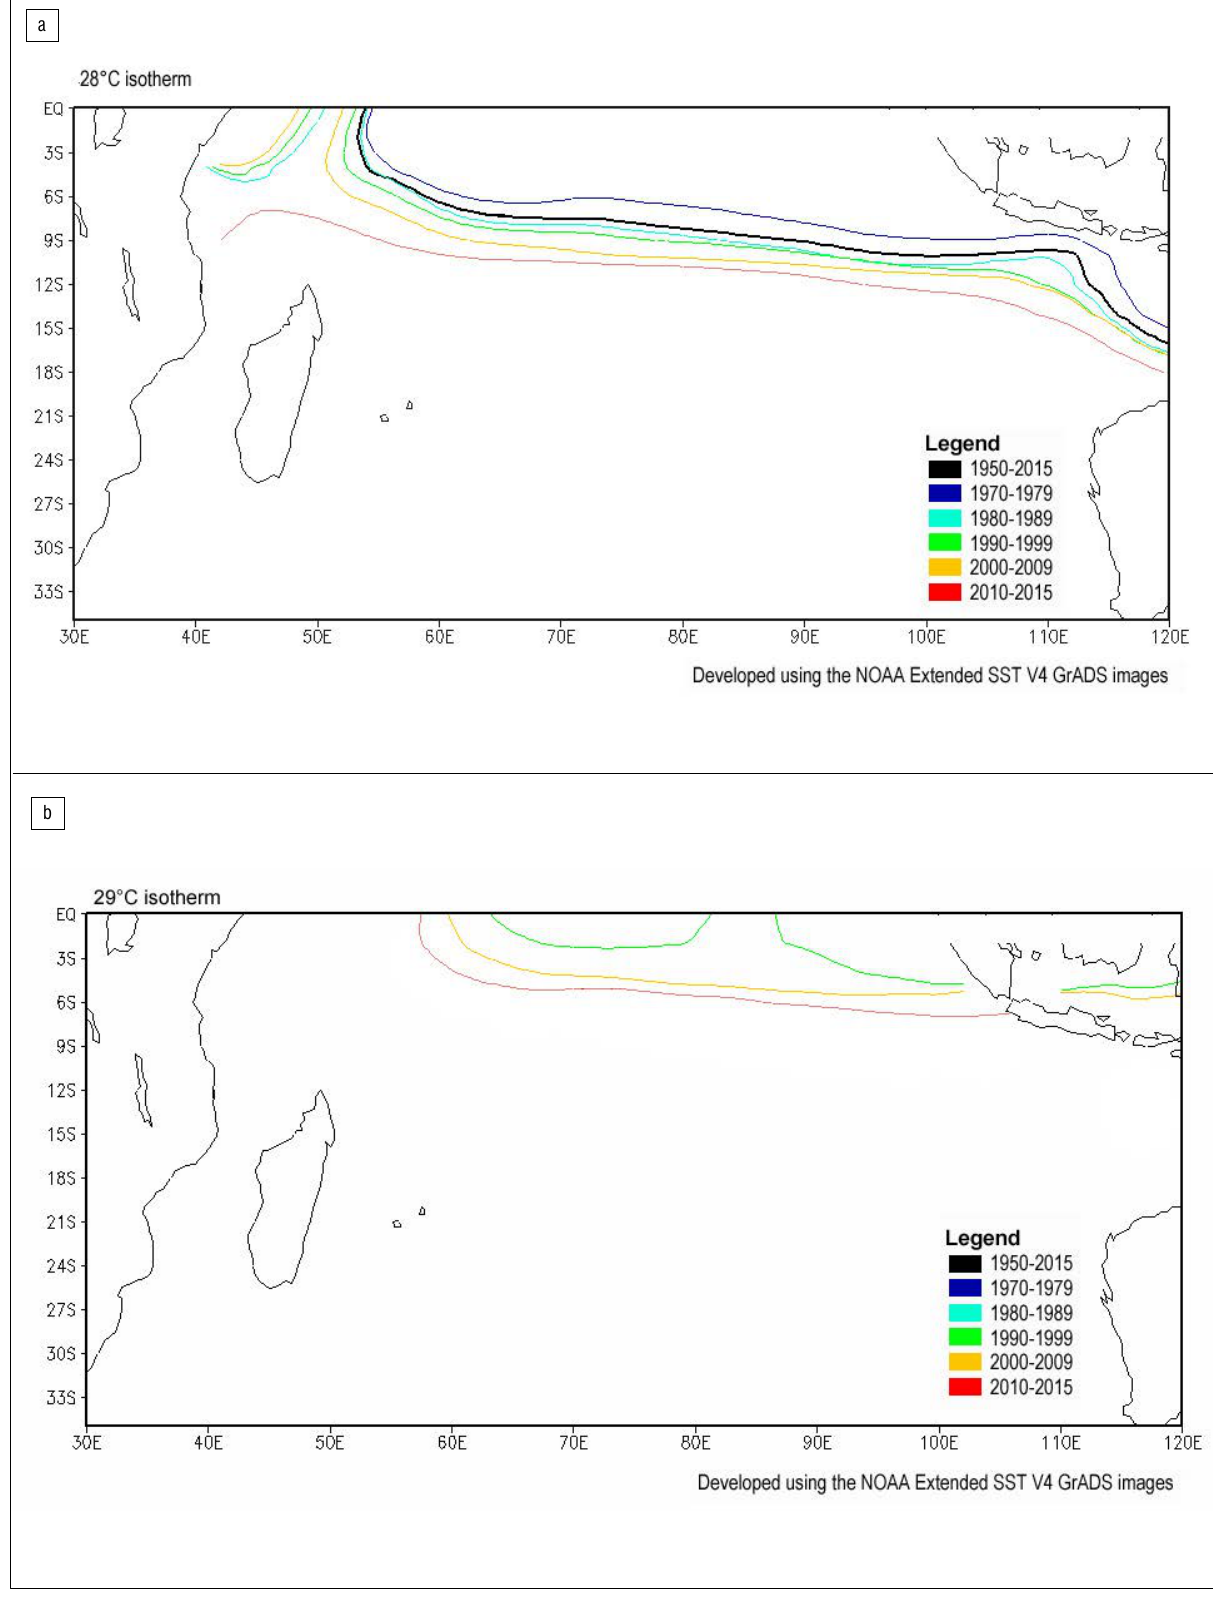
figure 3: Decadal mean position of the (a) 28 °C and (b) 29 °C sea surface temperature isotherms for the South Indian Ocean over the period 1970–2015, relative to the 1950–2015 long-term mean (black